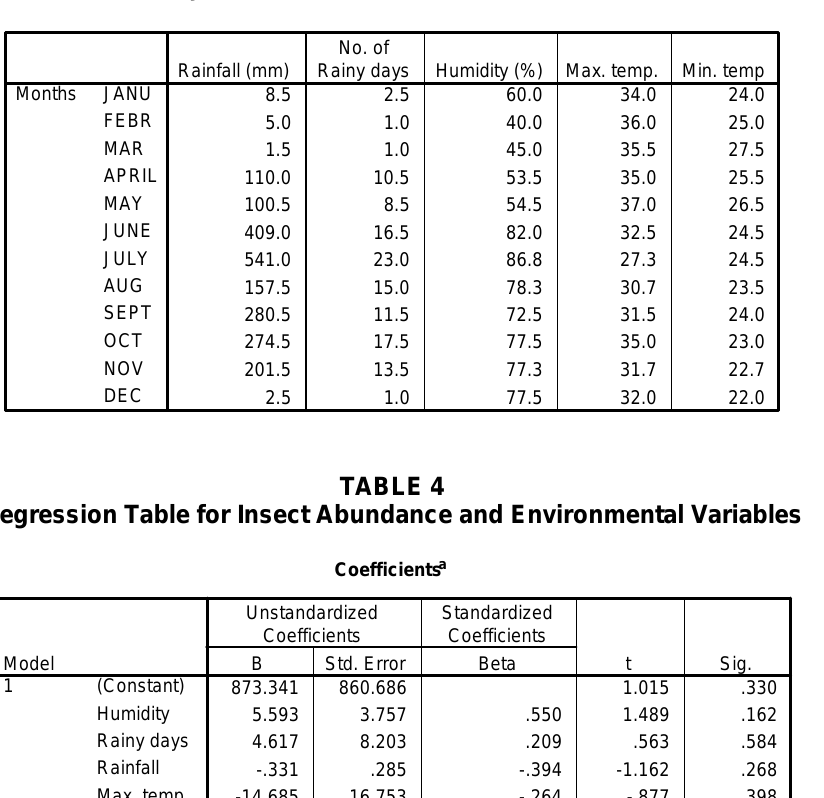
Mean Monthly Values of Environmental Variables Monitored